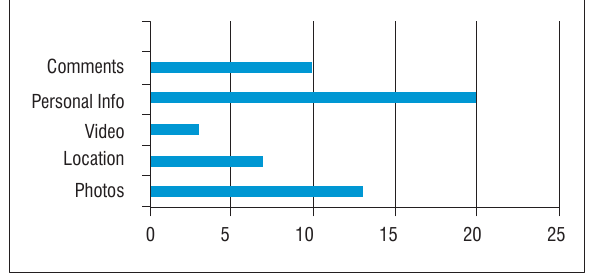
Figure 6: Information shared on users’ profiles.